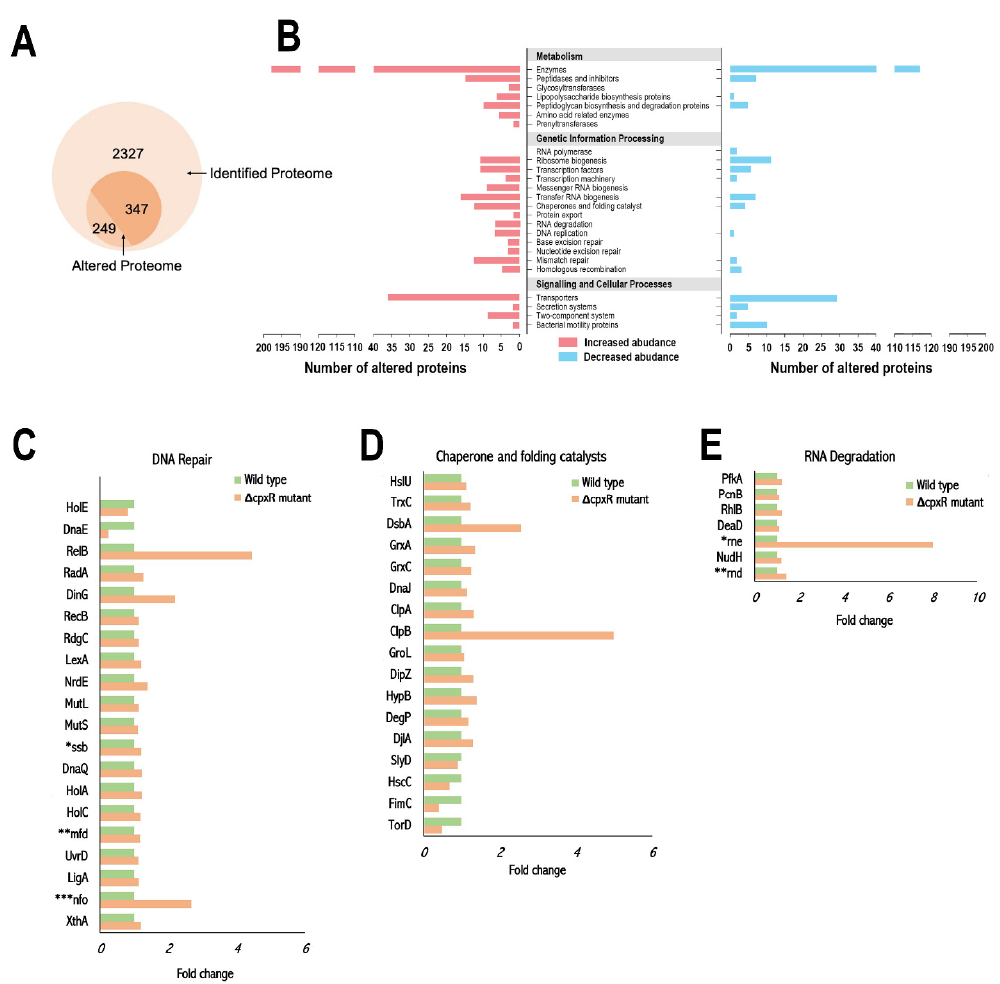
Figure 5. Effect of the cpxR deletion on the proteome of S . Enteritidis during the exponential growth phase. ( A ) Venn diagram showing the overall effect of the cpxR deletion on the proteome of S. Enteritidis. Approximately, out of 2327 identified proteins, one quarter (25.6%) of the proteome was altered. There were 347 proteins with increased abundance and 249 proteins with decreased abundance compared with that of the wild-type. ( B ) Protein ontology enrichment analysis portraying the biological processes that have been altered by the deletion of the cpxR gene. All proteins that showed statistically significant differences, including the permutation test and Benjamini-Hochberg method ( p < 0.023), as well as high reproducibility across the biological replications were analyzed, ( C–E ). Fold change in protein abundances of proteins involved in ( C ) DNA repair, * single-stranded DNA-binding protein SSB1, ** transcription-repair coupling factor, *** deoxyribonuclease IV ( D ) chaperone and folding catalysts and ( E ) RNA degradation, * ribonuclease ( E ), ** ribonuclease ( D ). These three graphs indicate the alterations of these three groups of proteins in the ∆ cpxR background compared with the wild-type during the exponential growth phase.